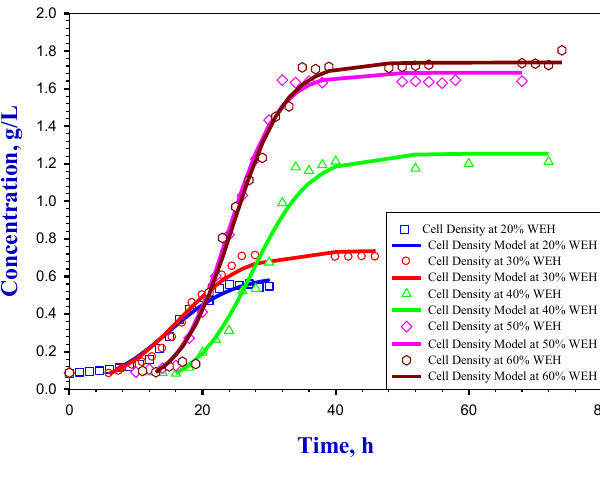
Figure 2. Experimental data and model results of recombinant E. coli FBWHR growth during concentrated hot-water wood extract hydrolyzate fermentation.